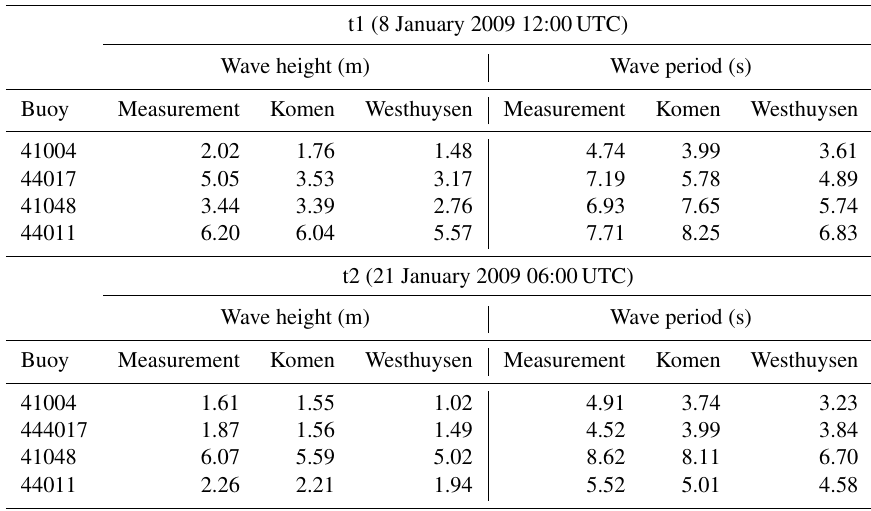
Table 2. Simulated wave heights and mean periods using Komen and Westhuysen whitecapping methods at reference times t1 and t2 compared to observations at the four NDBC